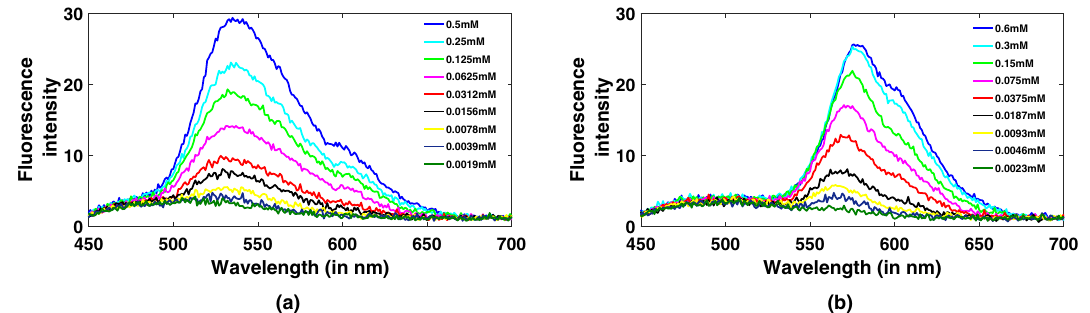
Figure 6. Fluorescence spectra of ( a ) FAD and ( b ) Rhodamine for different concentrations from smartphone- based prototype.